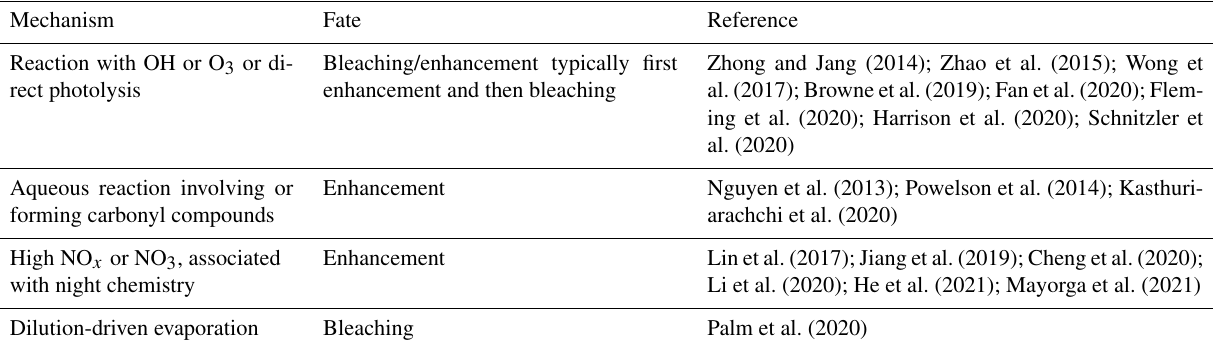
Table 1. Summary of processes that produce (enhancement) or remove (bleaching) BrC following emission.